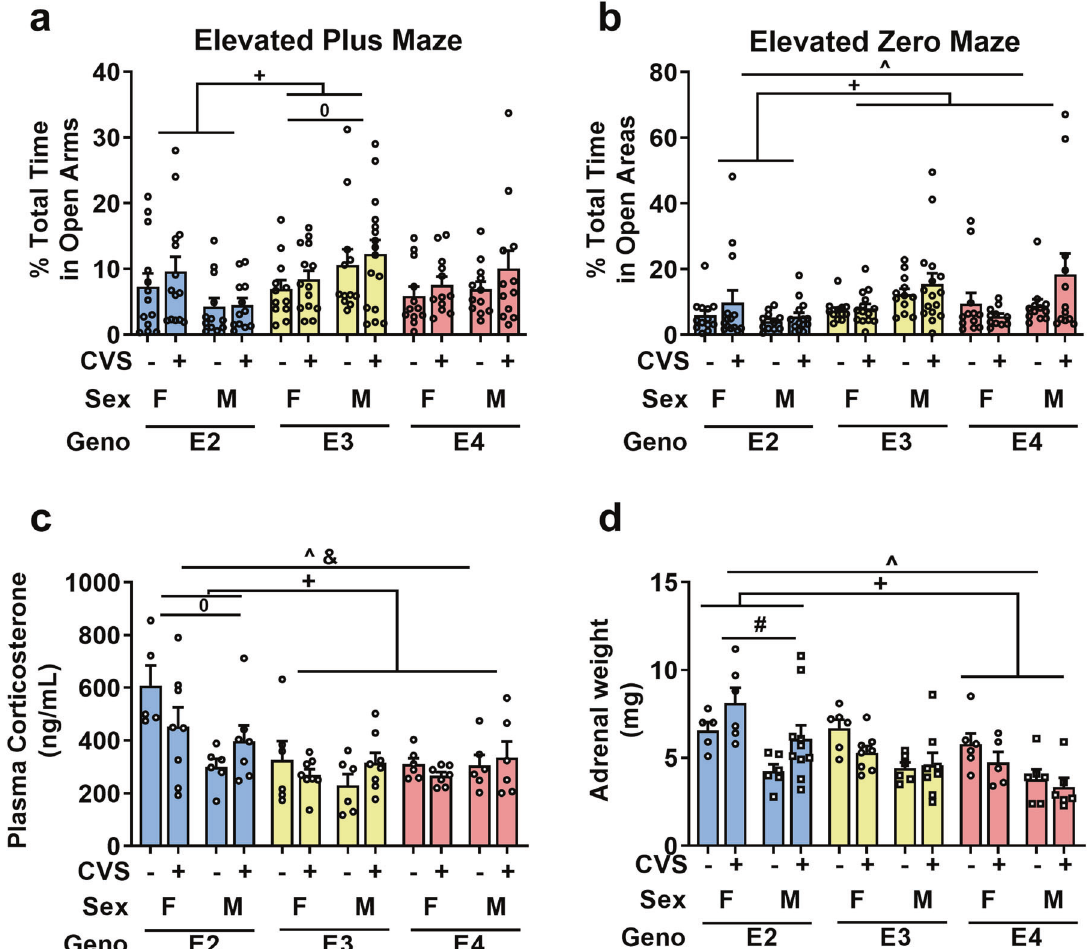
Fig. 3 Behavioral and physiological anxiety-related measures. a E2 mice spent signi fi cantly less time in the open arms of the elevated plus maze compared to E3 mice ( + p < 0.05). E3 females also spent less time than E3 males (^ p < 0.05). b E2 mice again explored the least time in the open areas of the elevated zero maze ( + p < 0.05). Males explored the open areas more than females (^ p < 0.05). c Plasma corticosterone levels after a mild stressor (elevated zero maze) showed that females had higher levels compared to males (^ p < 0.05) which was driven by the difference in E2 mice ( 0 p < 0.05 ) . E2 mice had the highest corticosterone levels ( + p < 0.05). There was also an interaction between sex x group driven by the lower corticosterone levels seen in female mice exposed to CVS ( & p < 0.05). d Adrenal glands were dissected after all behavioral testing. Females had heavier adrenal glands than males (^ p < 0.05). E2 mice had the heaviest overall ( + p < 0.05) and CVS exposed E2 mice had larger glands compared to their genotype-matched controls (* p < 0.05). Symbols: + refers to pairwise comparison of genotype effect, ^ refers to sex effect, * refers to CVS effect, # refers to genotype x CVS interaction, 0 refers to sex x genotype interaction, & refers to sex x CVS 6.73, p = 0.002; E2 vs E3: p = 0.001). Within genotype, sex three non-target quadrants was analyzed separately for each group (Fig. 2f, g). Except for female E2 CVS mice, all mice showed an effect of quadrant (ANOVA: E2 female controls: F 3,30 = 4.32, p = 0.012; E3 female controls F 3,33 = 18.15, p < 0.001; E4 female controls F 3,33 = 4.31, p = 0.011; E3 female CVS: F 3,39 = 7.78, p < 0.001; E4 female CVS: F 3,30 = 4.86, p = 0.007; E2 male controls: F = 9.41, p < 0.001; E3 male controls F = 24.36, p < 0.001; E4 zero maze (Fig. 3b, F 2, 137 = 5.75, p = 0.004; E2 vs E3: p = 0.007, E2 3,30 3,33 male controls; F 1.71, 18.76 = 4.60, p = 0.028; E2 male CVS: F 3,45 = vs E4: p = 0.023). Female mice explored the open areas of the zero 5.27, p = 0.003; E3 male CVS: F 3, 39 = 12.64, p < 0.001; E4 male CVS: maze less than males ( F 1, 137 = 6.23, p = 0.014). CVS exposure did F = 17.34, p < 0.001). Pairwise comparisons within each group not result in group differences in the time spent in the open areas 3, 33 of the elevated zero maze. demonstrated that the effect of quadrant was due to more time Plasma corticosterone, the major corticosteroid in rodents, was being spent within the target quadrant except for female E2 CVS measured immediately after mice completed the elevated zero mice. Following reversal training, no group showed preference for the new target quadrant (Supplementary Table 2). lower plasma corticosterone levels compared to controls whereas male CVS mice had higher plasma corticosterone levels compared to controls ( F 1, 68 = 4.82, p = 0.032). E2 mice had higher plasma E2 mice explored the open arms in the elevated plus maze less than E3 mice, suggesting higher anxiety levels (Fig. 3a, F 2, 137 = corticosterone levels compared to E3 and E4 ( F 2, 68 = 8.70, p <